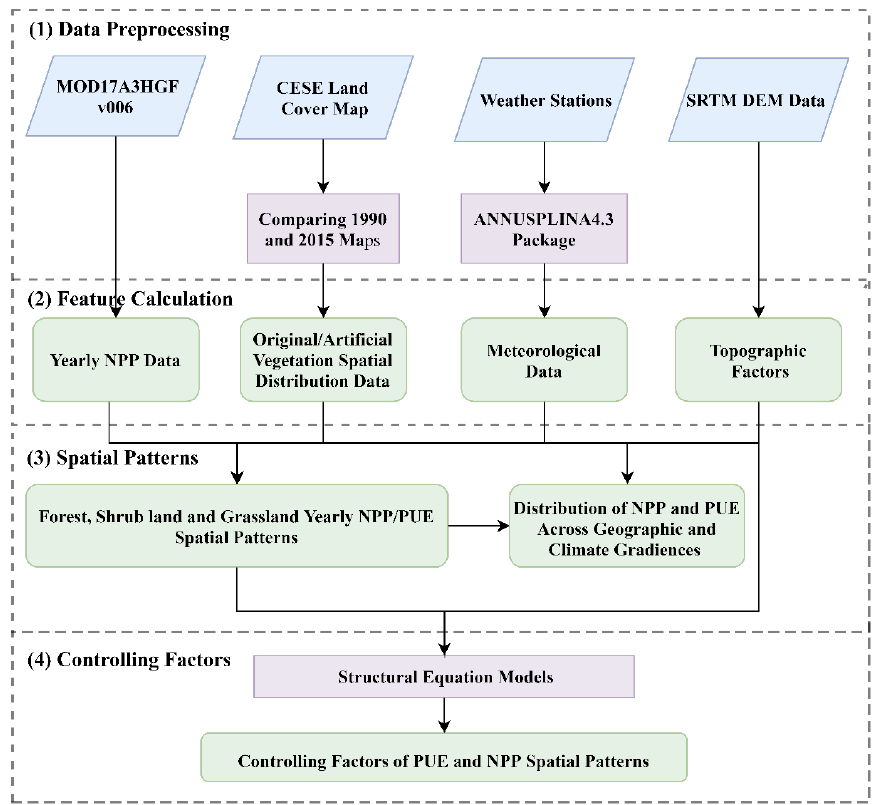
Figure 2. The flowchart of the data processing steps and methodology applied in this study.